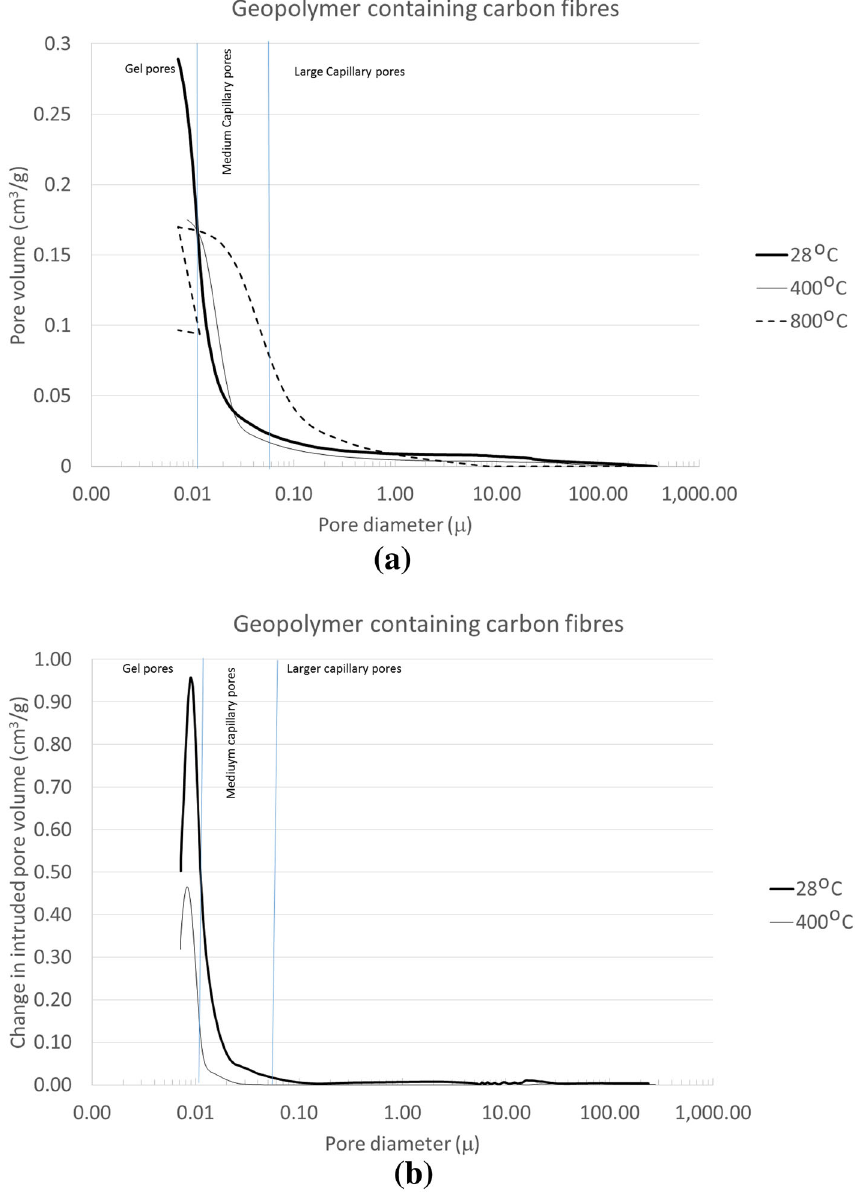
Fig. 8 Cumulative pore volume of 1 wt% carbon and basalt fibre reinforced geopolymer at ambient and at various elevated temperatures. a Carbon fibre reinforced geopolymer composite and b Basalt fibre reinforced geopolymer